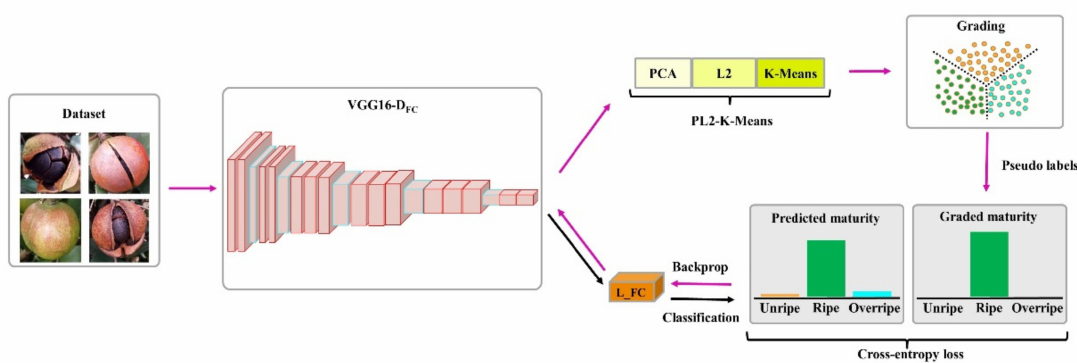
Figure 3. Overview of all processes in the proposed Camellia oleifera fruit maturity grading and identification model based on unsupervised image clustering, VGG16-D FC model indicates the VGG16 network with the last fully connected layer removed, L_FC denotes the last fully connected layer of VGG16, L2 represents the L2